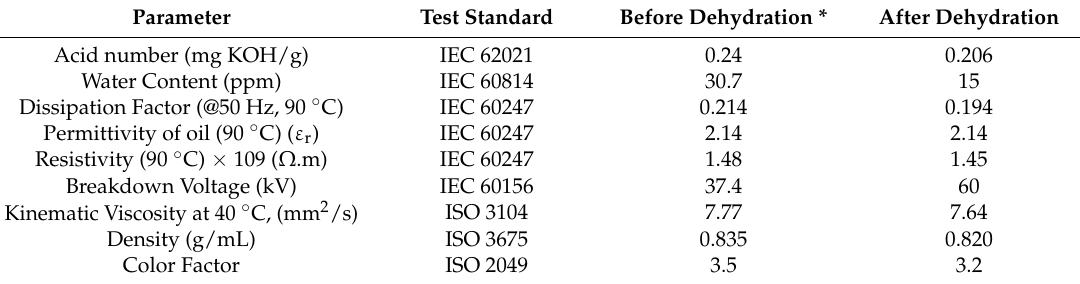
Table 1. Characteristics of the transformer oil before and after